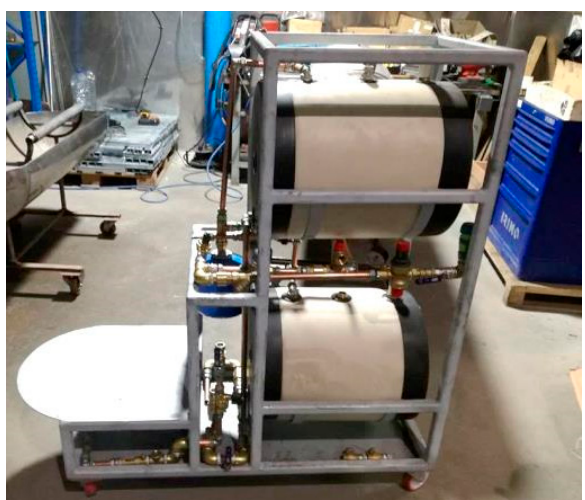
Figure 3. Mechanical system.